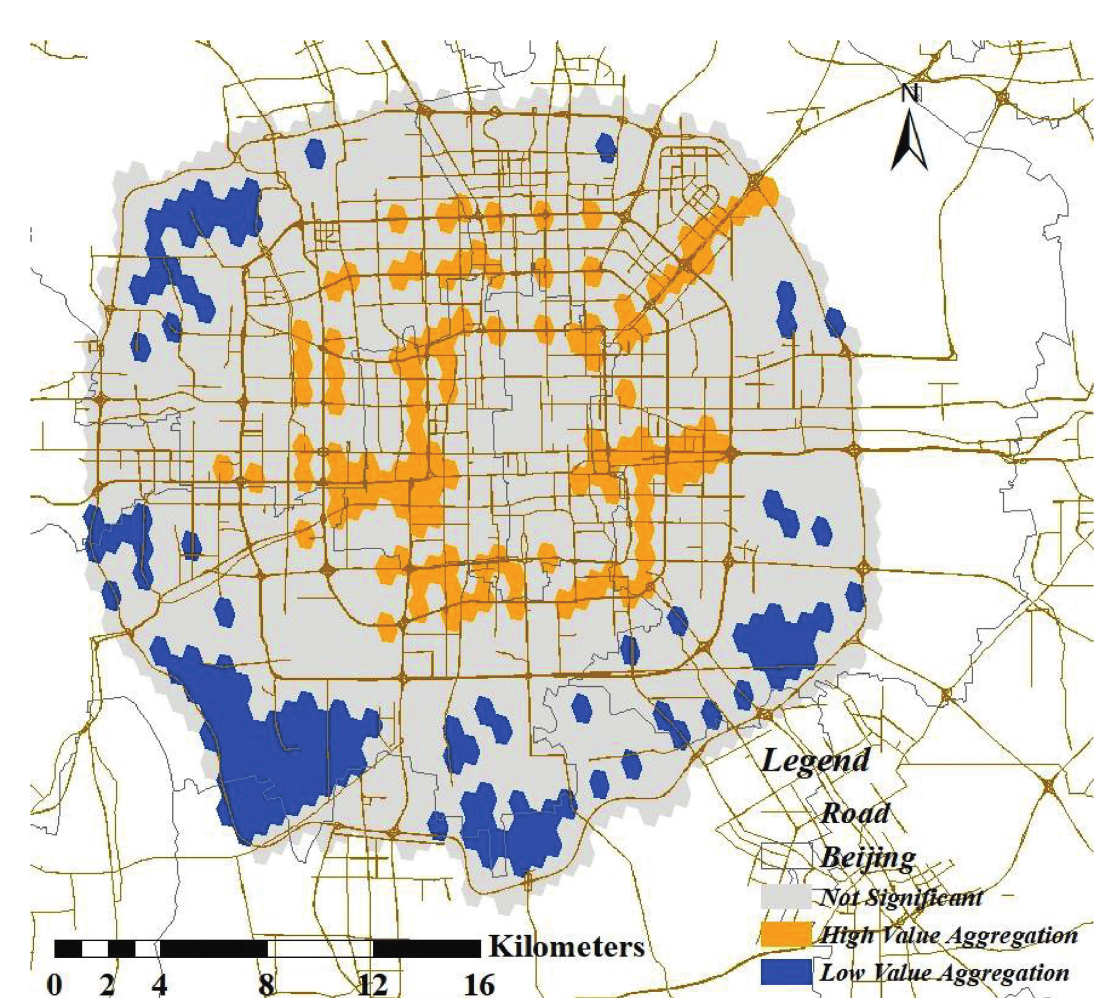
Figure 16: The final cluster map based on